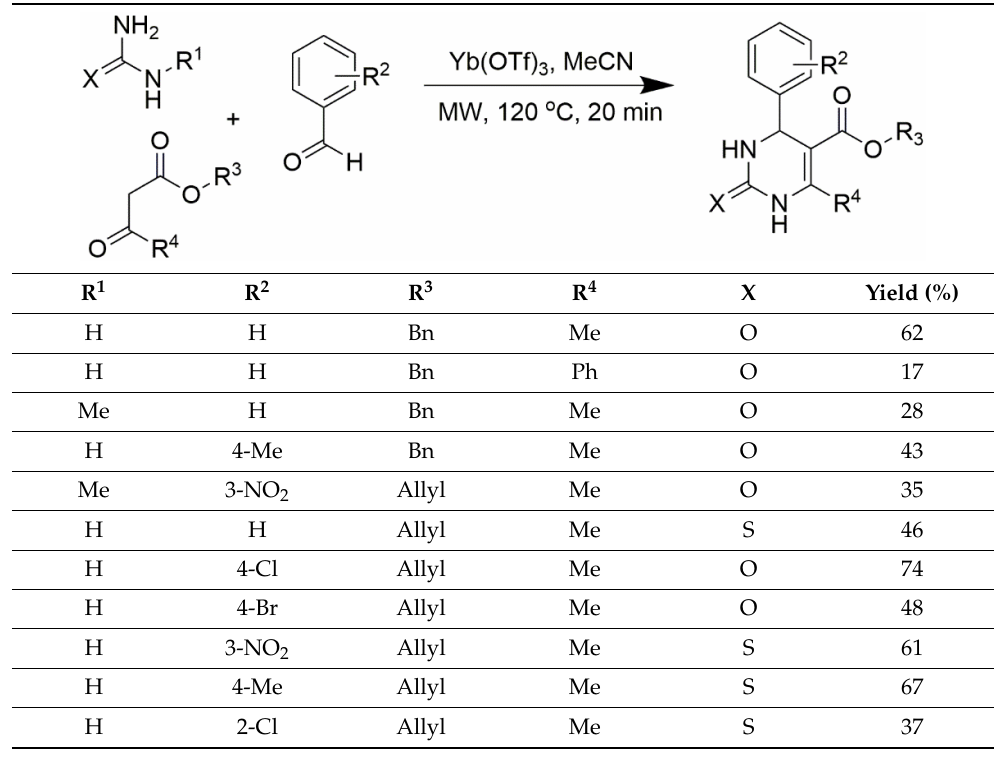
Table 3. Yb(OTf) 3 used in the Lewis acid microwave-assisted synthesis of DHPMs offering substitu- tion at the C5 position.